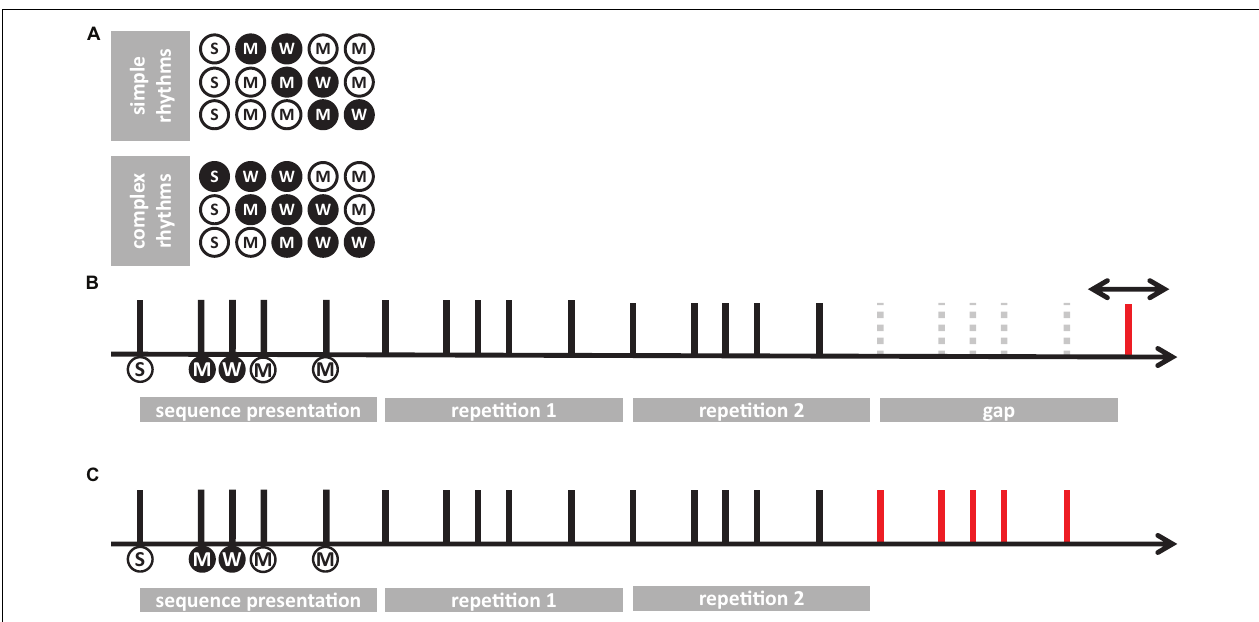
FIGURE 1 | A schematic of the experimental procedures. (A) representation of simple and complex rhythms adopted in the present study. Each circle represents a unit of the sequence. White and black circles denote long and short elements, respectively. Letters in the circles indicate the predicted level of perceptual accent for each element: “S” for strong, “M” for medium; “W” for weak. (B) trial example from temporal-order task (experiment 1). Each vertical line represents the onset of the element for a given sequence (e.g., 21122). Circles below the lines report the length and the perceptual accent for each element (following the symbol conventions from A ). The sequence was presented 3 times in succession, then—after an interval gap of the duration of the sequence plus a random jitter—a probe was presented (red line). Participants had to report whether the probe was presented before or after the predicted onset of the imagined 5th sequence. (C) Example of reproduction task (experiment 2). After presenting the sequence three times, participants were asked to continue the reproduction (red line) for about 20 s, by tapping with their finger on a piezo-electric